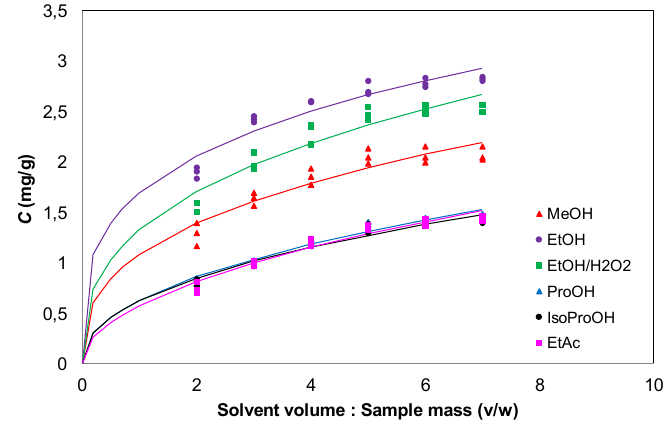
Figure 1. Effect of solvent/sample ratio (v/w) on the quantity of extracted phenols from olive